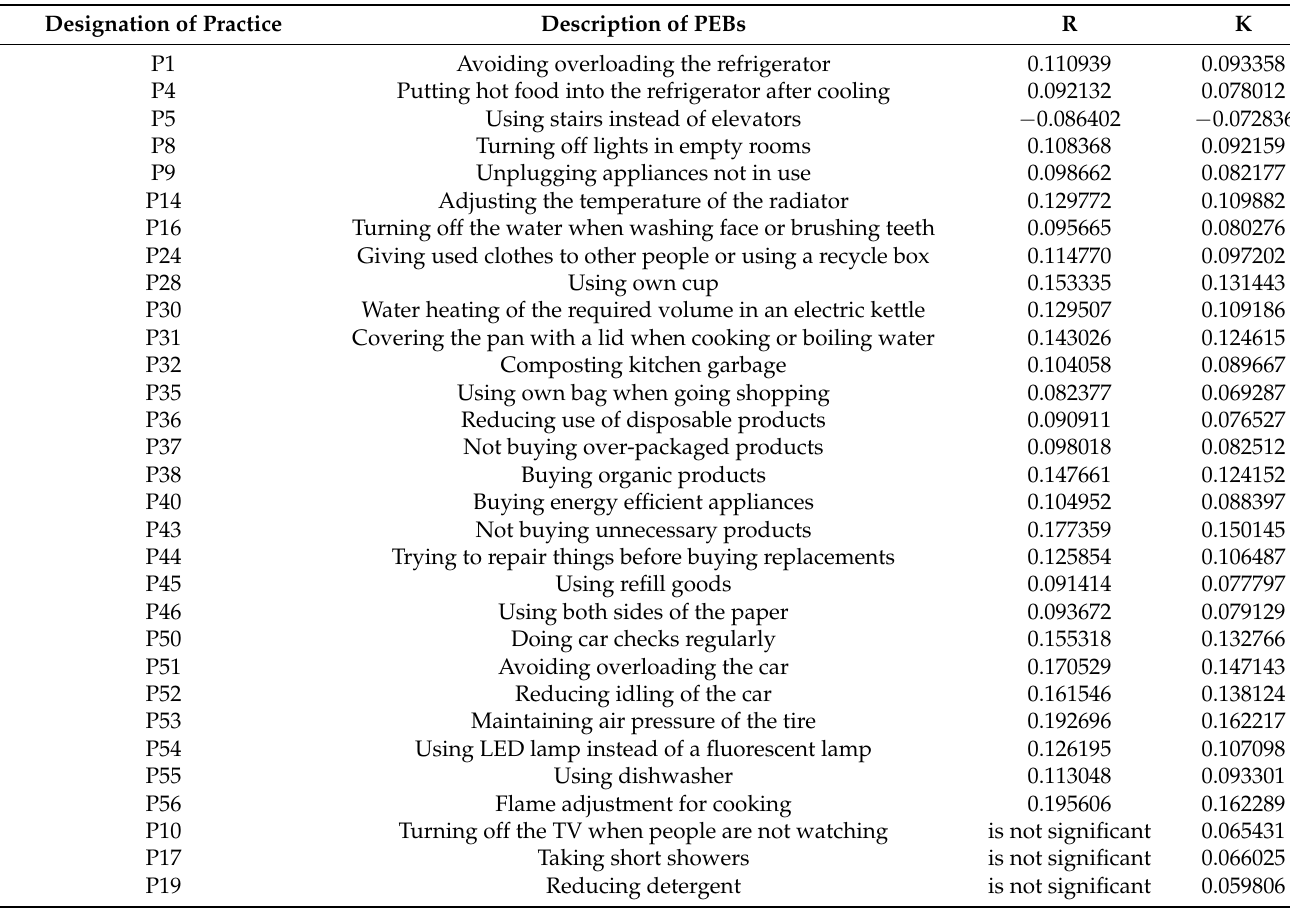
Table 3. Correlations (at the p = 0.05 level) between the respondent’s age and the frequency of using the practices of proecological behavior.